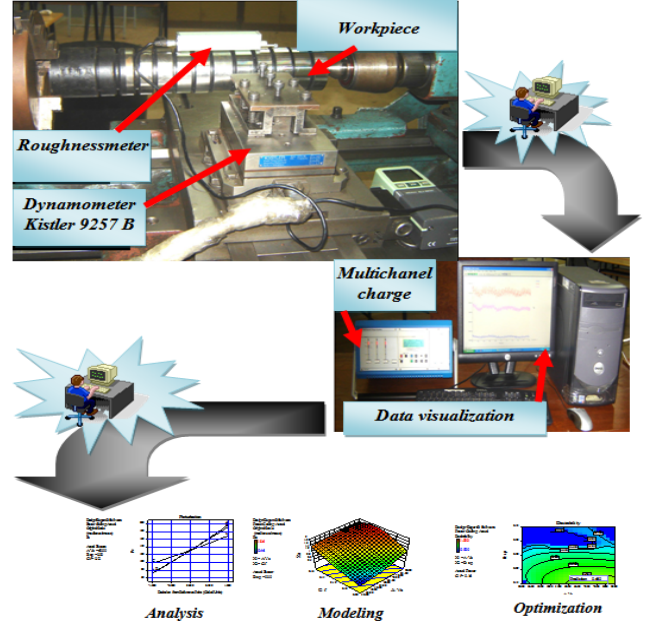
Fig.1. Set-up and design of experiments